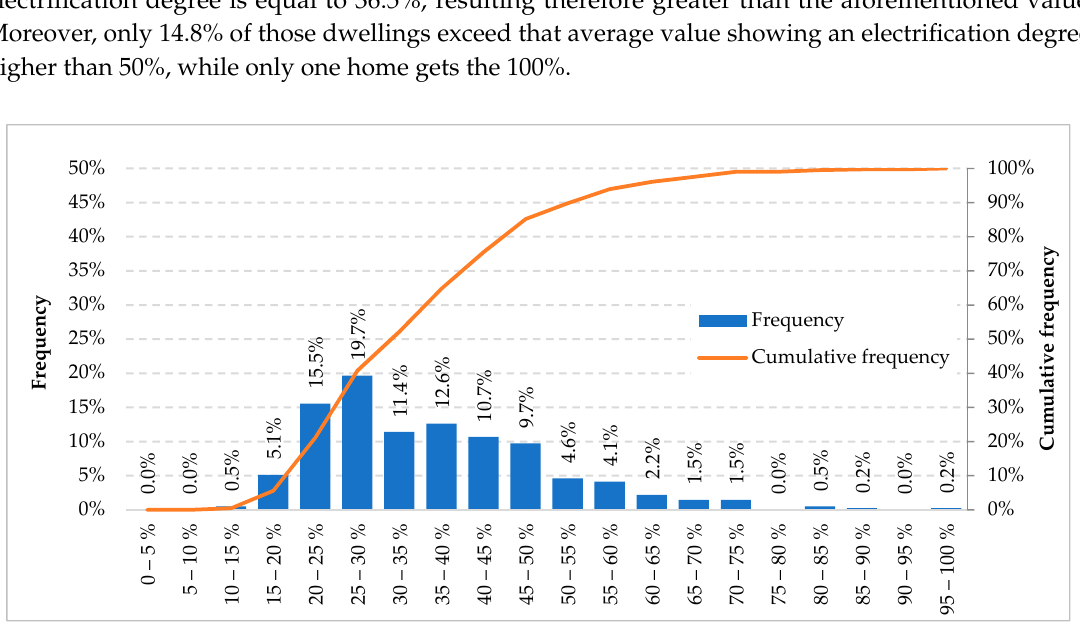
Figure 9. Dwellings electrification degree.